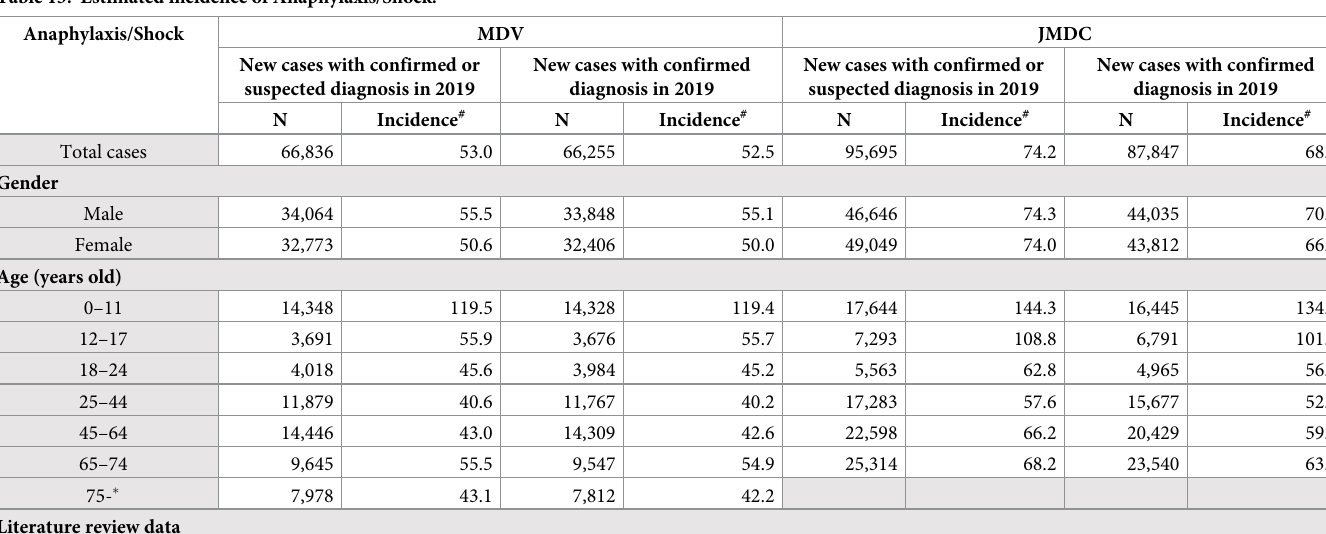
Table 13. Estimated incidence of